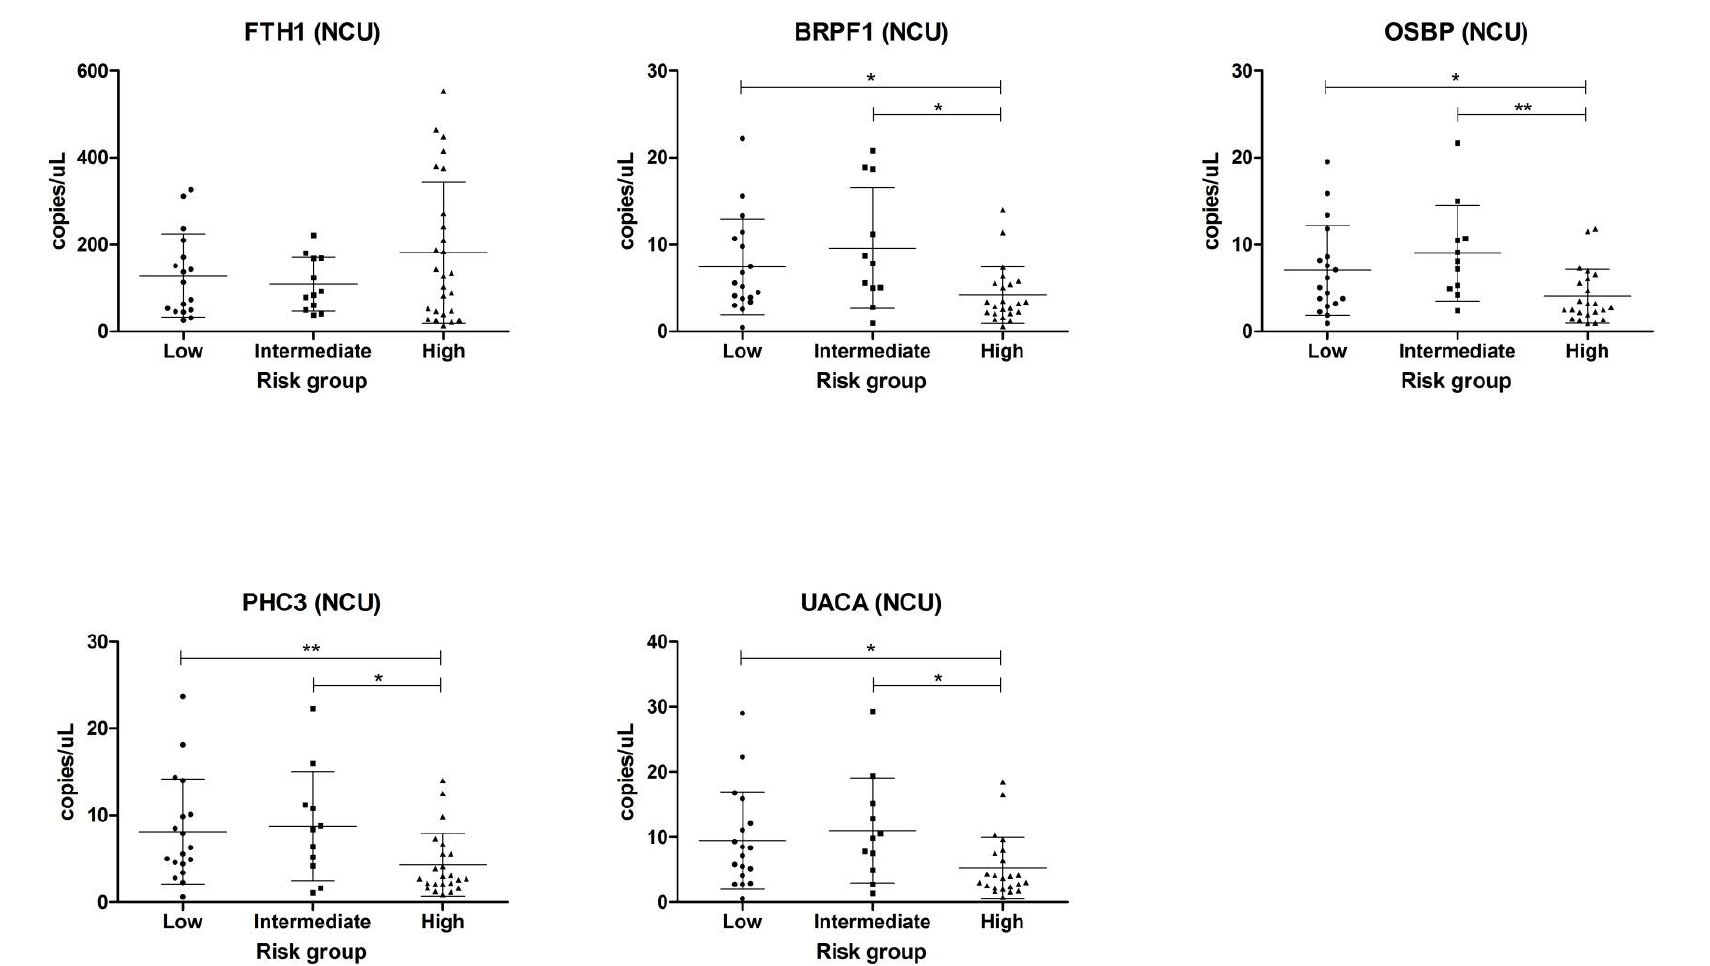
Figure 3. Expression levels of mRNA (copies/ μ L) in NCU samples classified according to risk groups in accordance with to the D’Amico score. Expression levels were compared using Mann–Whitney independent t-test (* p ≤ 0.05; ** p ≤ 0.01).